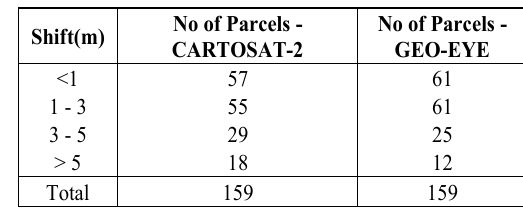
Table 7. Comparison of Position deviation with respect to ETS-GPS in CARTOSAT-2 and GEO-EYE